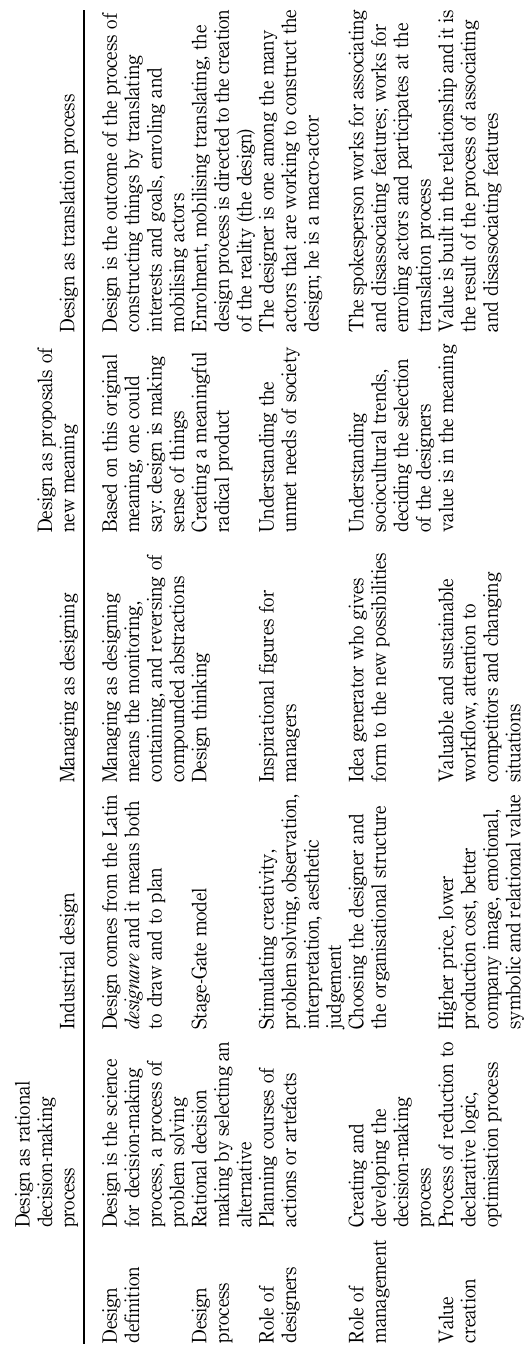
Table II. Overview of the